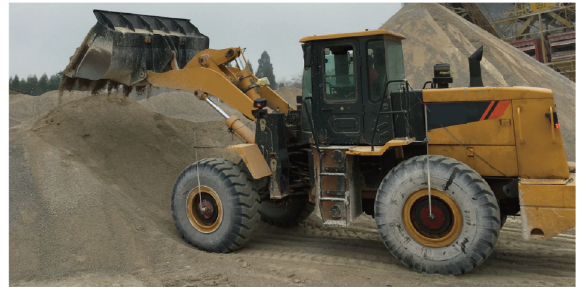
Figure 3. Experimental wheel loader.